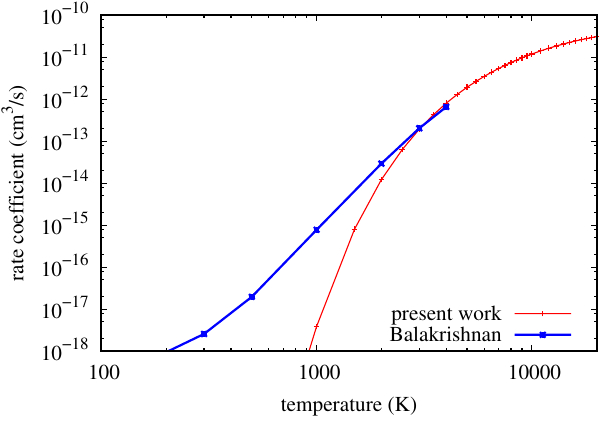
Figure 3. Rovibrational excitation in He + H 2 ( v = 2, j = 0) → He + H 2 ( v (cid:48) = 1, j (cid:48) = 8), as calculated by the quantum mechanical method (QM) [38] and by quasi-classical trajectory (QCT) (this